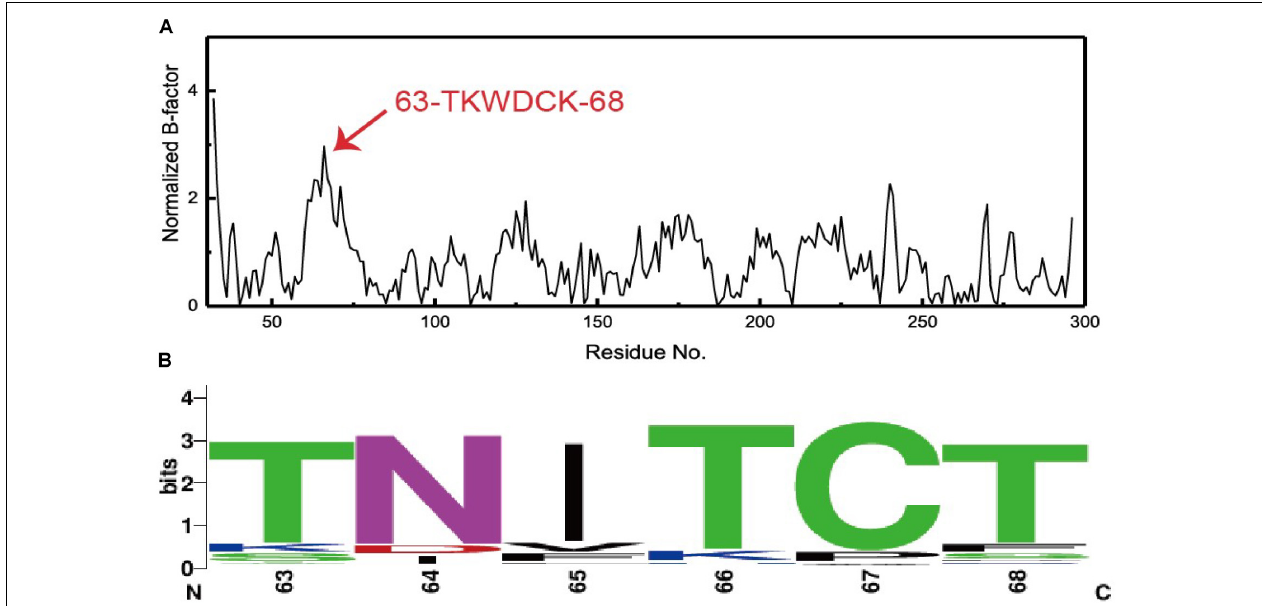
FIGURE 2 | (A) Normalized B-factor Lipr27RCL and (B) multiple sequence alignment based on 92 lipase sequences from different species of thermophilic fungi.